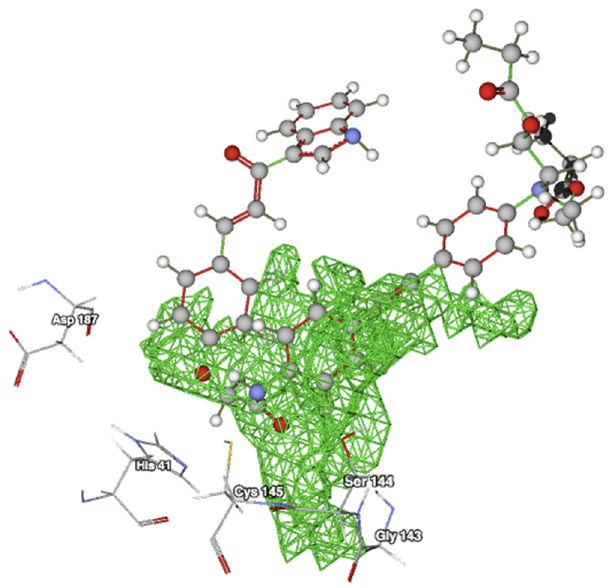
Figure 4. Interactions between 15 and the catalytic side of the SARS-CoV-2-M pro . Regarding the obtained pose for 15 (Figure 4), the key interactions are depicted in Figure 5. The principal residues of the SARS-CoV-2-M pro that interact with 15 are the Ser1, His164, and Phe305 in the case of the hydrogen bond interactions and His41 and Glu166 for the electrostatic interactions.